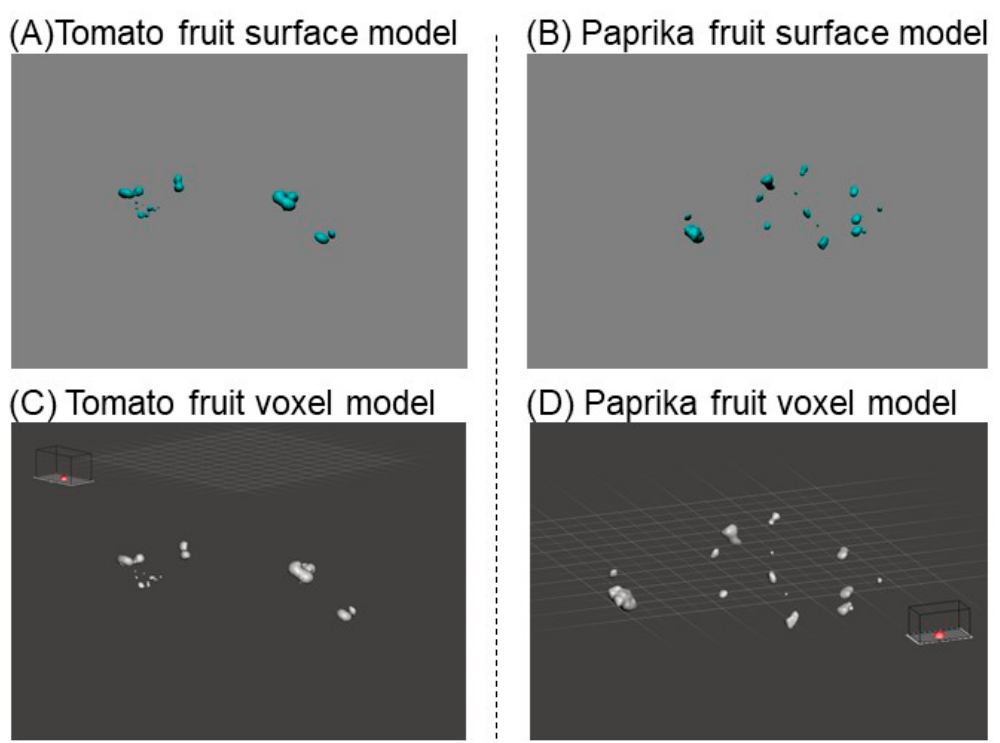
Figure 6. Fruit surface and voxel models. The fruit surface model was constructed by the fruit point cloud using OPT cloud survey (DPI-8X, Opt Technologies Co., Ltd., Tokyo, Japan) ( A , B ). The fruit voxel model was constructed from the surface model using Meshmixer 3.5 (Autodesk Inc., San Rafael, CA, USA) ( C , D ).